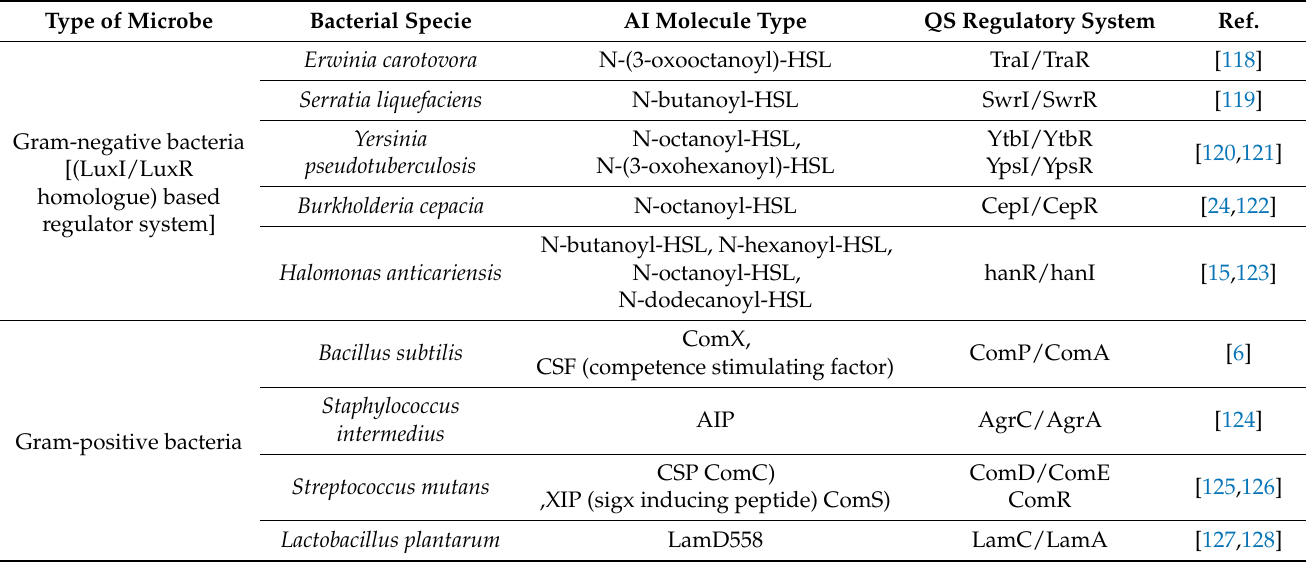
Table 3. QS regulatory systems and autoinducers present in both Gram-negative and Gram- positive